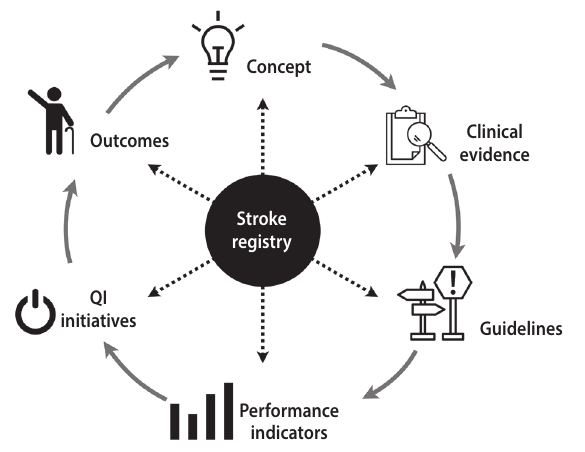
Figure 1. The role of the stroke registry in the cycle of quality improve- ment. Adapted from Bhatt et al. J Am Coll Cardiol